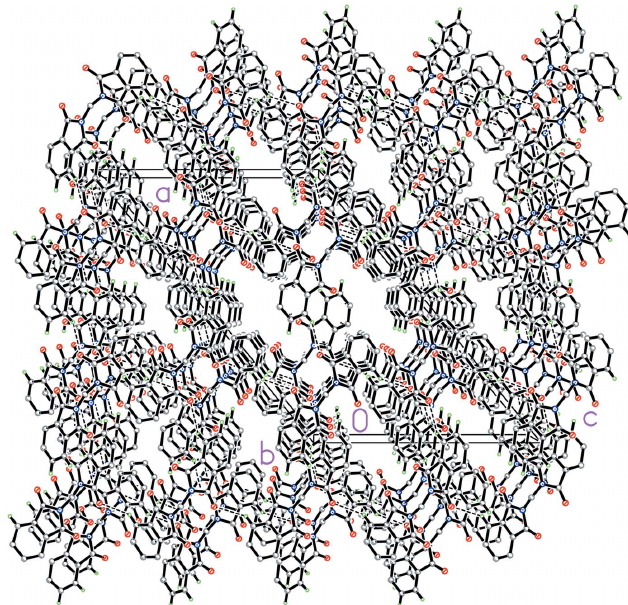
Figure 3 A partial crystal packing diagram of 1 (cid:3) viewed along the b axis. Dashed lines represent weak intermolecular C—H (cid:4)(cid:4)(cid:4) O hydrogen bonds. Hydrogen atoms which are not involved in hydrogen bonding are omitted for clarity.